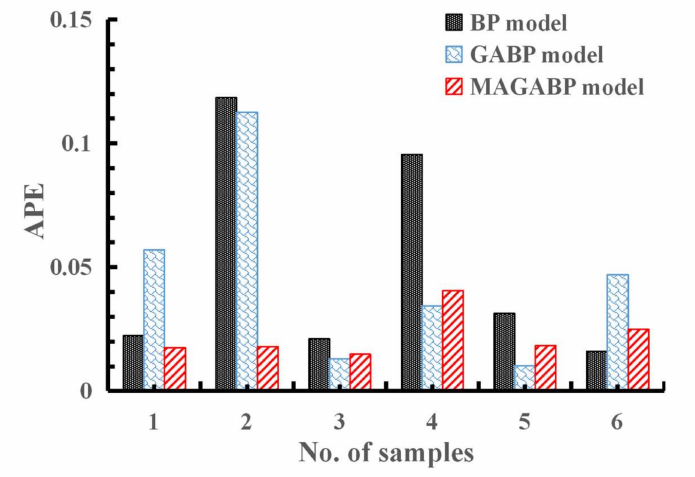
Figure 12. Absolute percentage error (APE) of di ff erent prediction